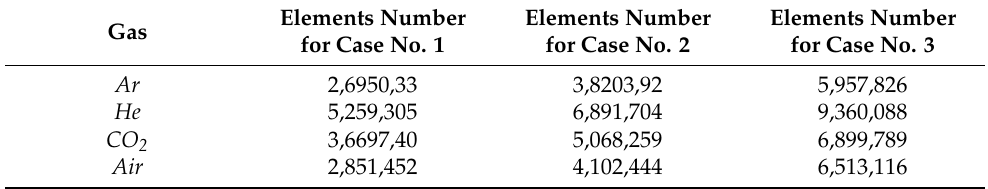
Table 5. Grid independence analysis for SVT with the same Reynolds number without the inner body. Elements Number Elements Number Gas for Case No. 1 for Case No. 2 for Case No.